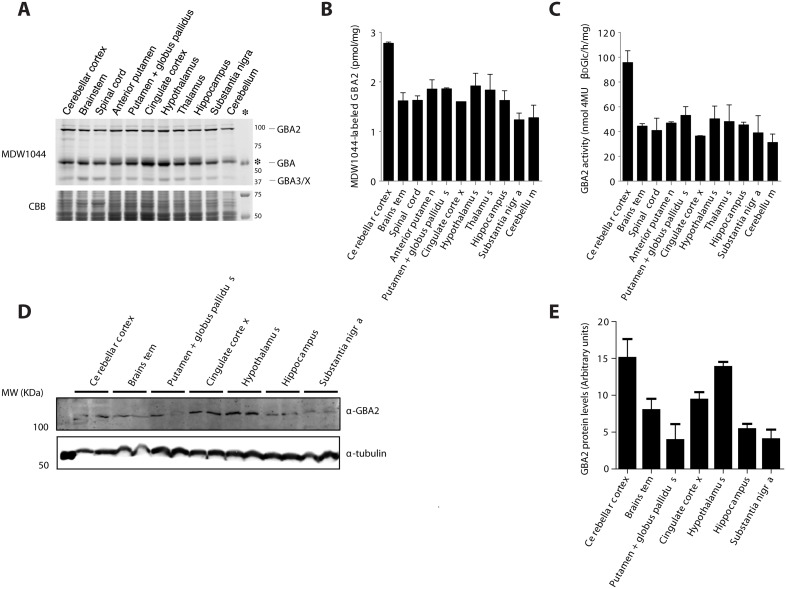

In vitro labeling of GBA2 in specific brain areas.(A) SDS-PAGE gel of Anybody MDW1044 labeled rat brains areas. (B) Quantification of Anybody MDW1044 fluorescent signal per μg of protein. (C) GBA2 enzymatic activity in different brain areas. (D) GBA2 protein levels in homogenates of rat brain areas assessed by Western blot analysis. (E) Quantification of GBA2 blot in rat brain areas normalized to the same tubulin signal showed in Fig 3e. Note: cerebellum indicates other parts of cerebellum than cerebellar cortex.